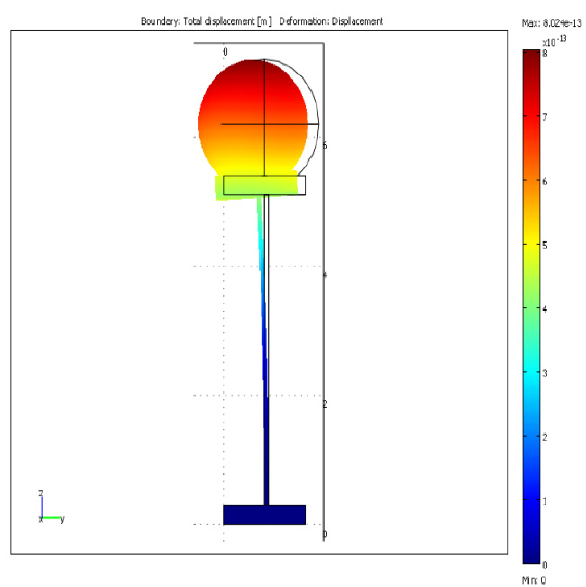
Figure 5. Total deformation of the bio-complex.